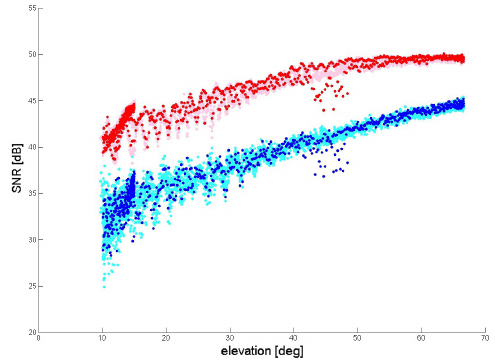
Figure 3: The L1 and L2 SNR data referring to the EPDN station and satellite 16. Light red and light blue points represent the SNR-L1 and SNR-L2 data of the three days before and after the eruptive event; dark red Figure 4: A) The SNR-L2 difference between the meas- and dark blue points are the values obtained on 23 ured and the expected SNR-L2 values referring to the November 2013 for L1 and L2 EPDN station and all its linked satellites. Black points represent the SNR-L2 data, yellow lines are the ±3dB limit and red vertical lines represent the beginning and end of the 23 November 2013 event. B) Inverse of the